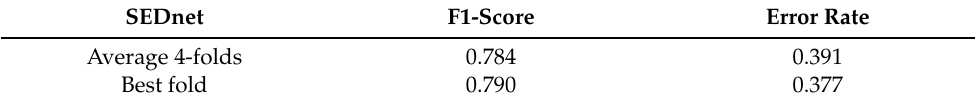
Table 2. Average F1-score and average error rate for the best fold and average labeling